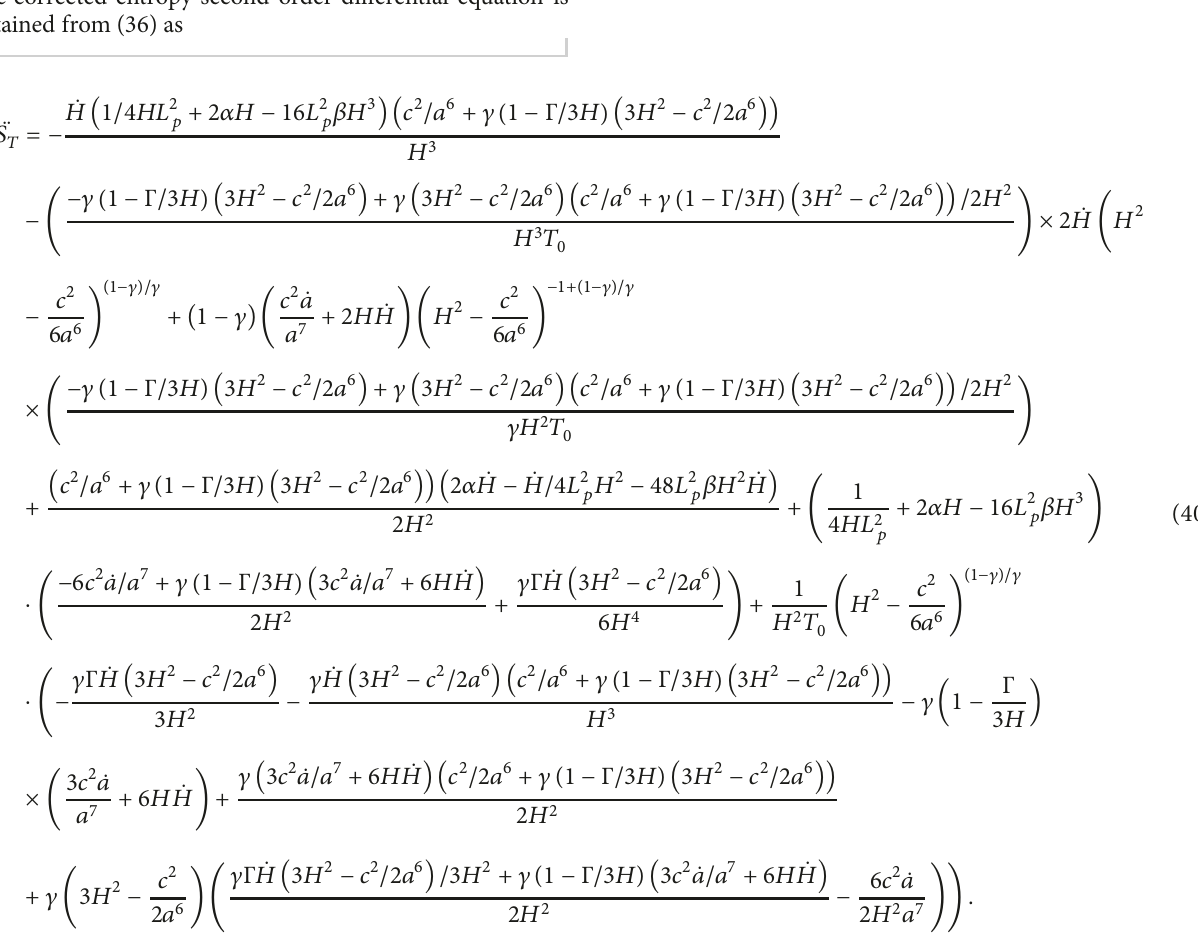
Figure 4: Plot of Logarithmic Corrected Entropy. In the presence of logarith-